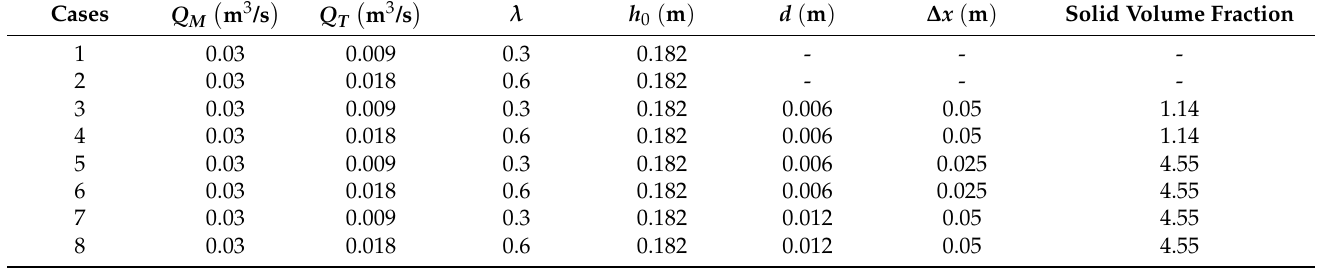
Table 4. Detailed information list of simulation cases.